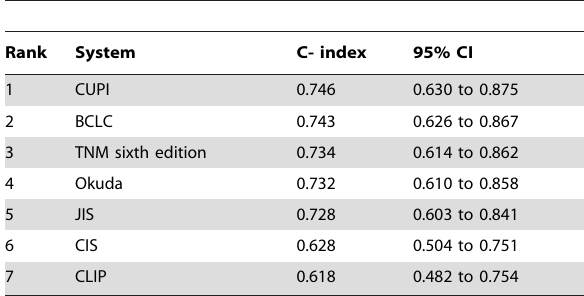
Table 4. Ranking of staging systems in patients with unresectable HCC by using c-index.